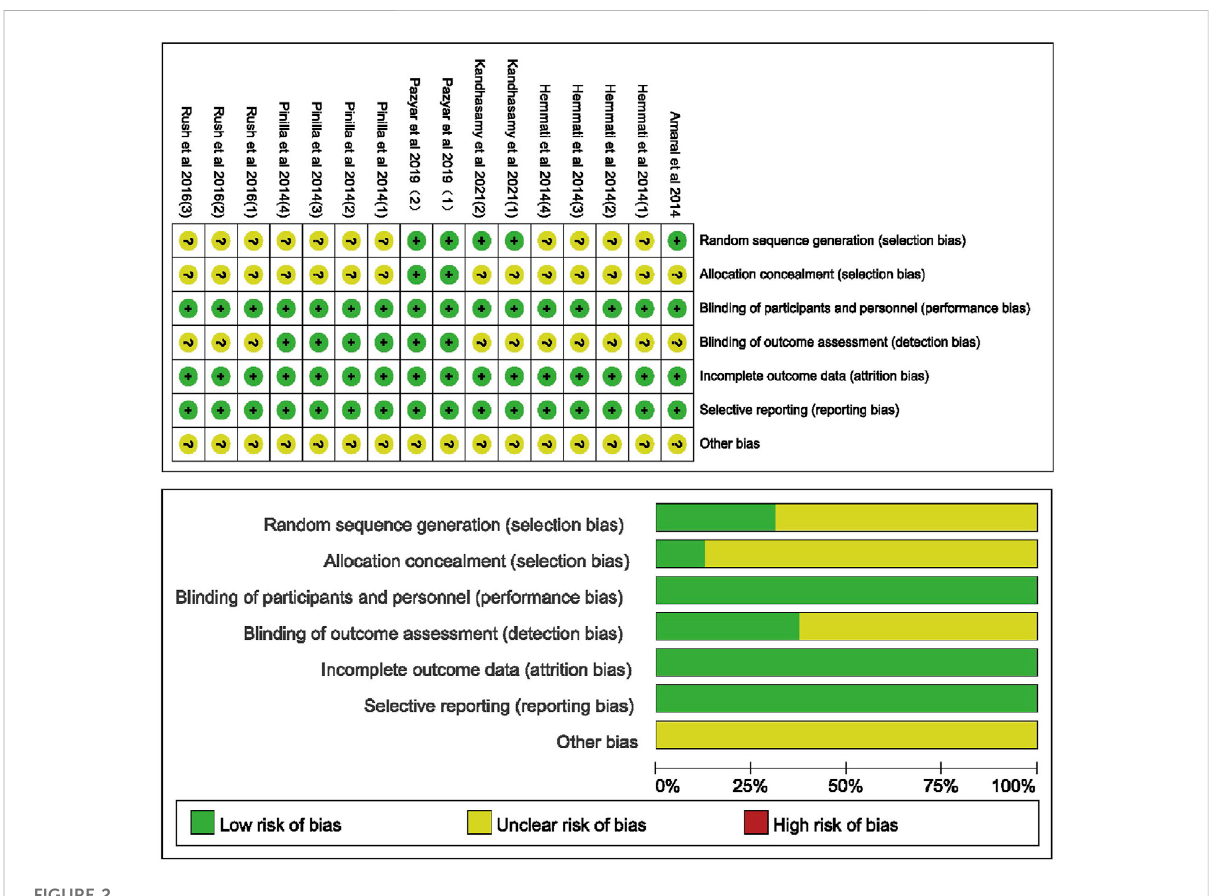
FIGURE 2 Risk of bias